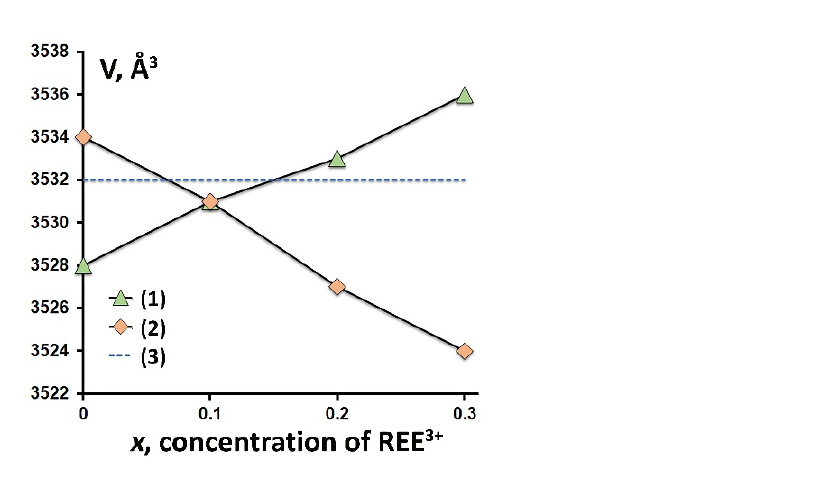
Table 1. The ionic radii difference D r between substituted and dopant ions.